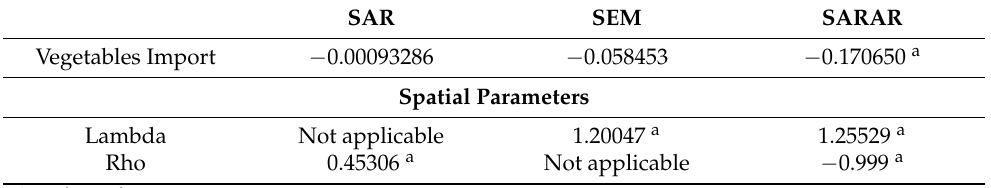
Table 5. Model parameters. Source: own calculations based on the raw data taken from Ref. [13]. SAR SEM SARAR Vegetables Import − 0.00093286 − 0.058453 − 0.170650 a Spatial Parameters Lambda Not applicable 1.20047 a